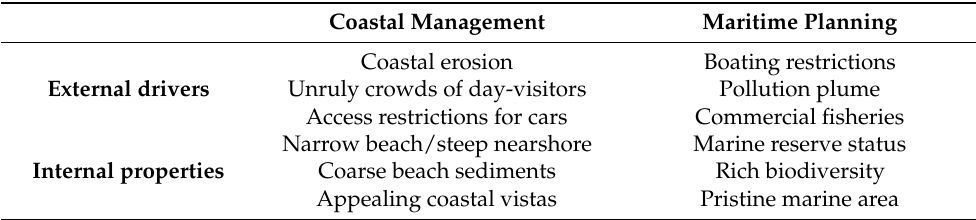
Figure 8. A “semiotic square” of oppositional relationships determining the situation of Karkl˙e as a seaside and marine resort in a CMPA (plotted by Ram¯unas Povilanskas). Table 6. Main oppositional relationships determining the situation of Karkl˙e as a seaside and marine resort in a